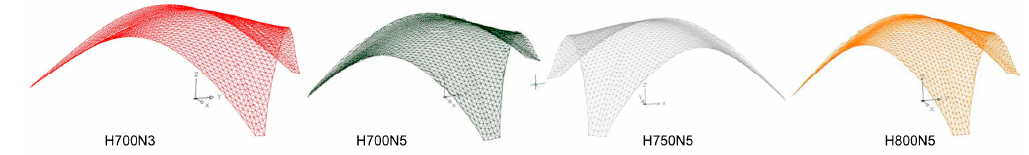
Figure 1. Iterations of the shape and three-dimensional meshes in the AutoCAD (Autodesk Inc.)